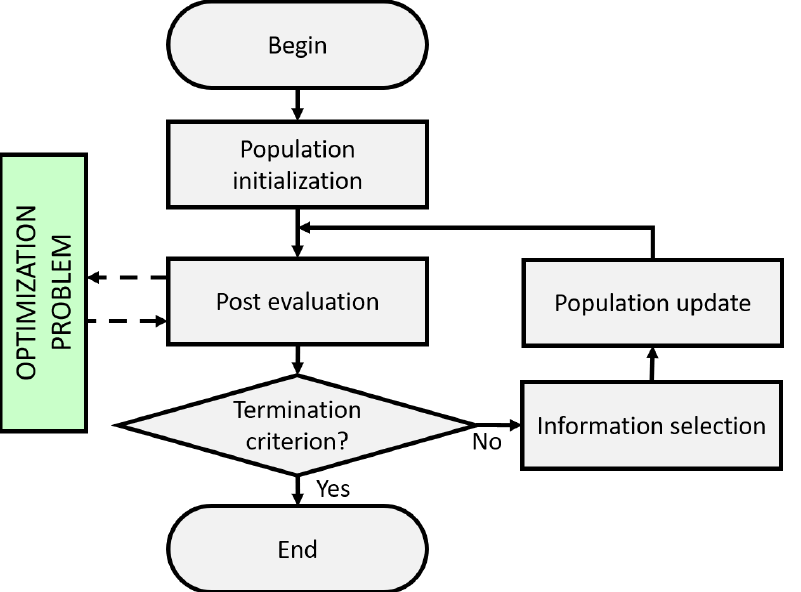
Figure 1. General flow chart of Social Network Optimization (SNO).